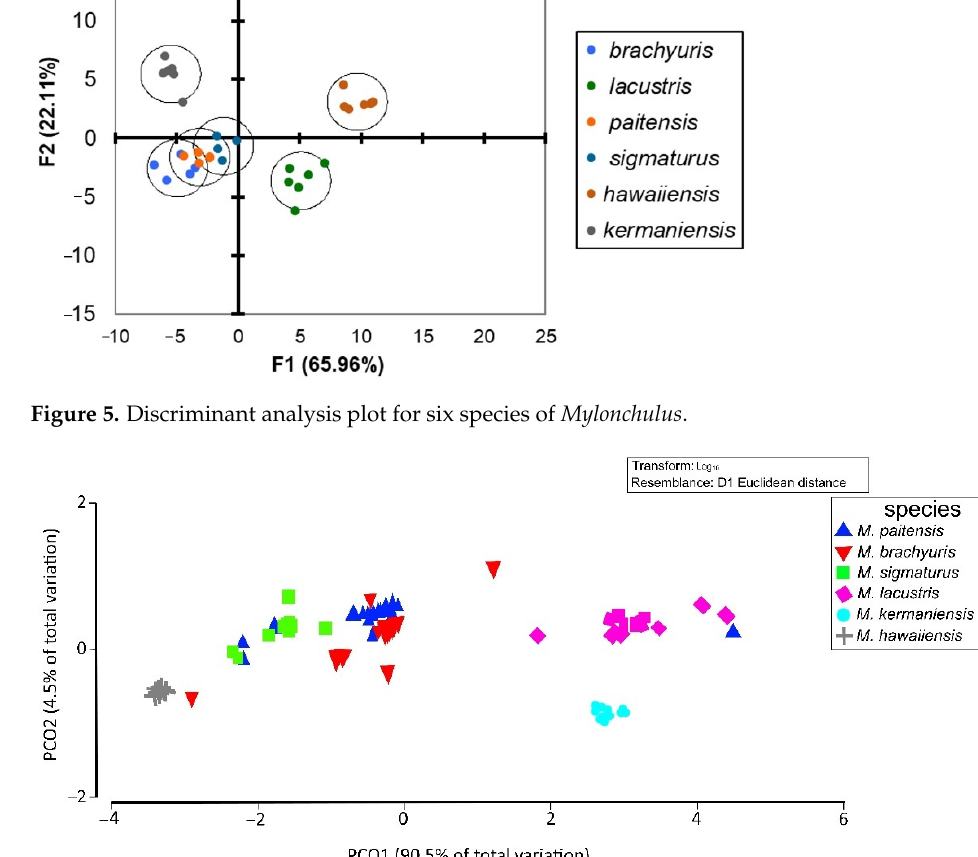
Figure 6. Principal coordinates analysis (PCoA) ordination indicates the relationships among pop- ulations for six species of Mylonchulus . Table 5. Permutational analysis of variance (PERMANOVA) for sixteen morphological traits in dif- ferent populations of Mylonchulus .